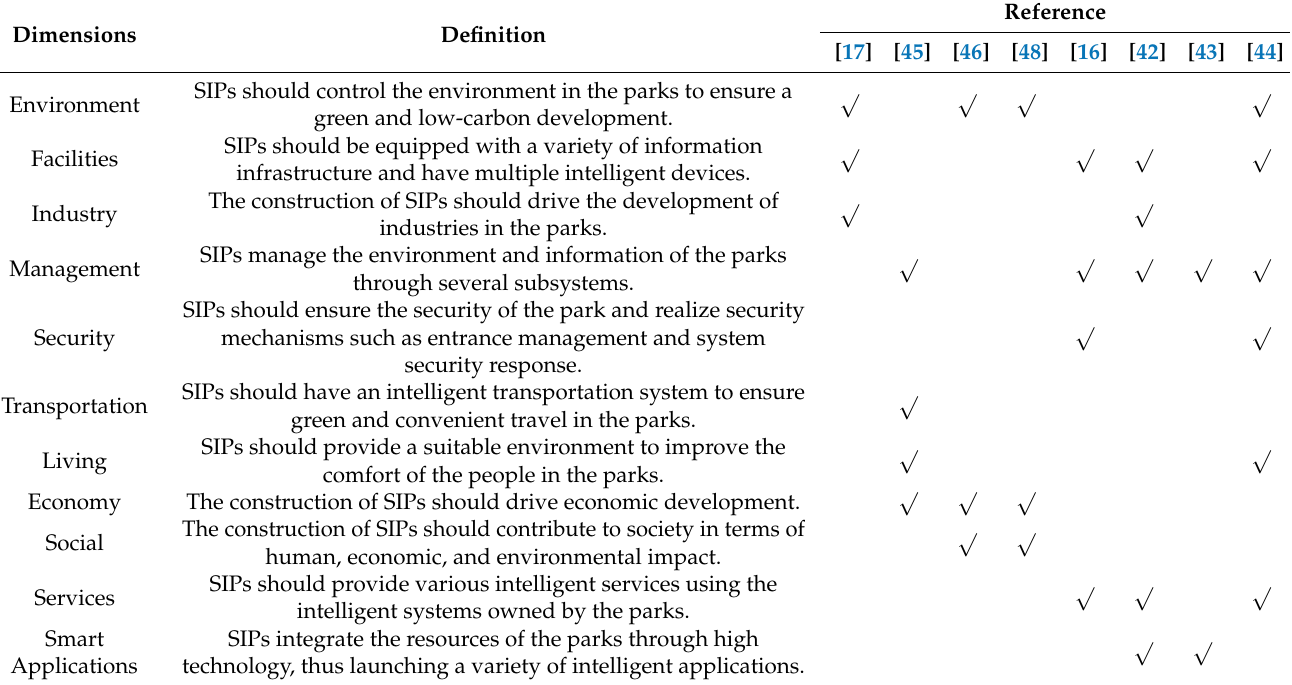
Table 3. Smart industrial park intelligence level dimension